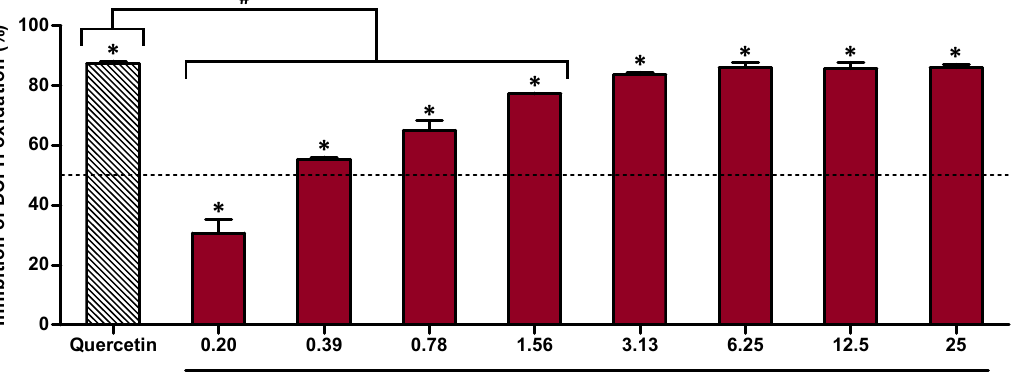
Figure 2. Antioxidant activity of the K. angustifolia extract on the human skin fibroblast WS1 cell line treated with tert -butyl hydroperoxide ( t -BuOOH), determined by a cell-based assay using DCFH-DA. All the experiments were carried out in at least triplicate and presented results are representative of at least two different experiments ( N = 2, n = 3). Data are presented as means of the triplicates ± S.D. The horizontal line is set at 50% inhibition. Statistical significance was determined using a one-way ANOVA followed by a Dunnett’s post hoc test ( p -value < 0.05 compared to control of cells treated with only t -BuOOH (200 µ M); * p -value < 0.05) or Bonferroni’s post hoc test ( p -value < 0.05 compared to positive control quercetin (1.56 µ g/mL); # p -value <